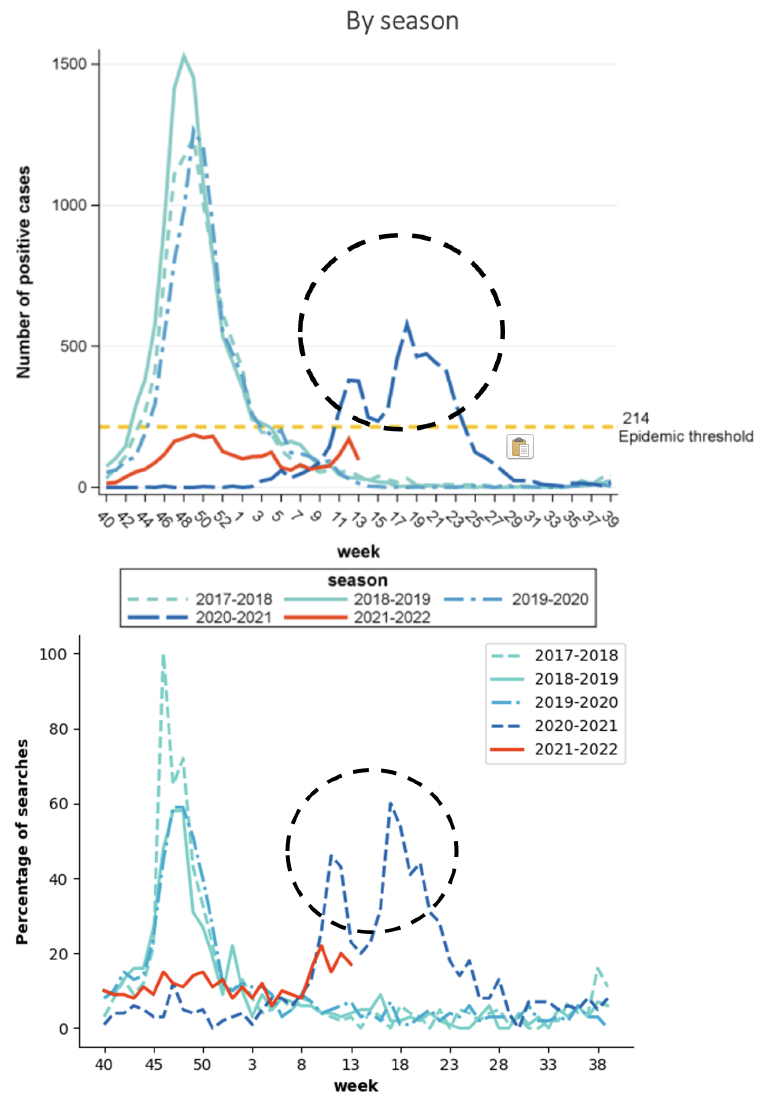
Figure 3. RSV seasonality for Belgium: identical patterns within each season (i.e., bimodal for season